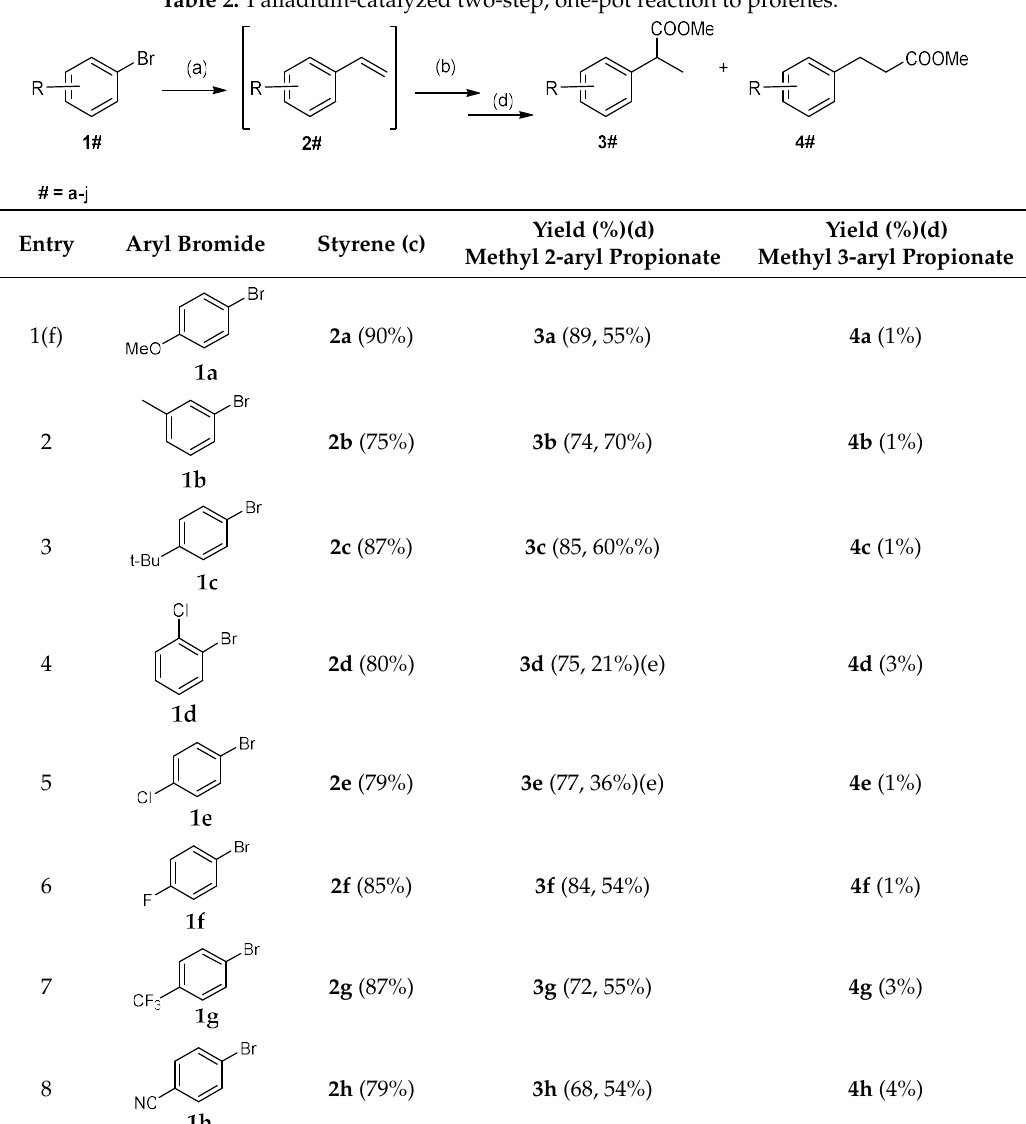
Figure 1. Molecular structure of NISPCDPP ( 9 ) in the crystal. Hydrogen atoms are omitted for clarity. Displacement ellipsoids correspond to 30% probability [24].